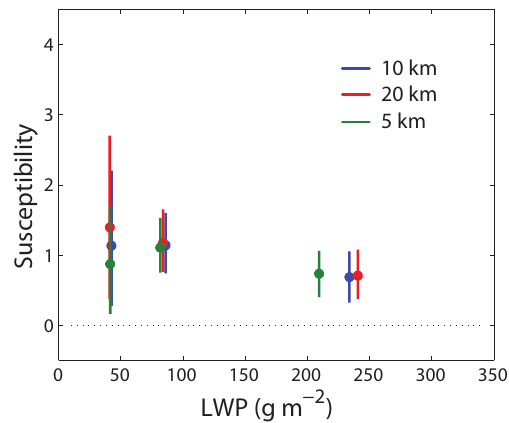
Fig. 7. The precipitation susceptibility is calculated in four equally weighted cloud liquid water path (LWP) bins for three different av- eraging length scales: 10km (blue), 20km (red), 5km